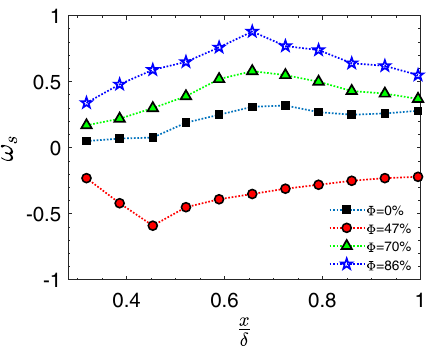
Figure 8. The variation of the viscous term in the vorticity evolution equation act as source and sink of the vorticity that causes the lift augmentation around the sediments.